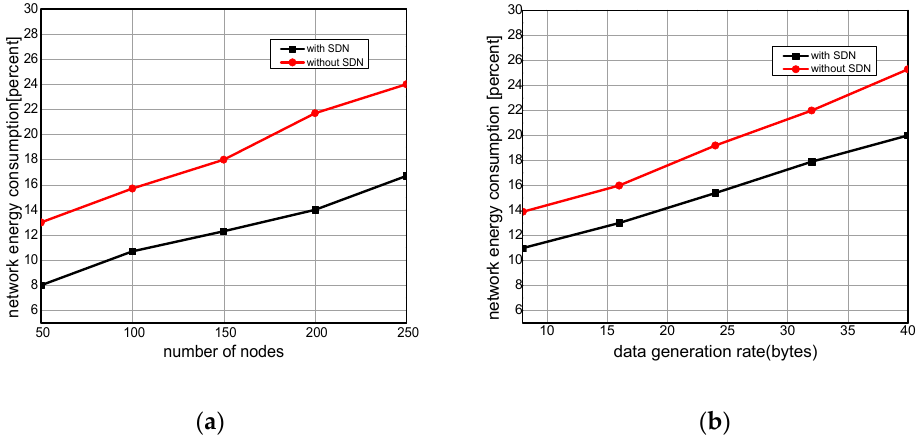
Figure 7. Performance of network energy consumption under a varying number of nodes ( a ) and packet generation rate ( b ) with and without SDN. packet generation rate ( b ) with and without